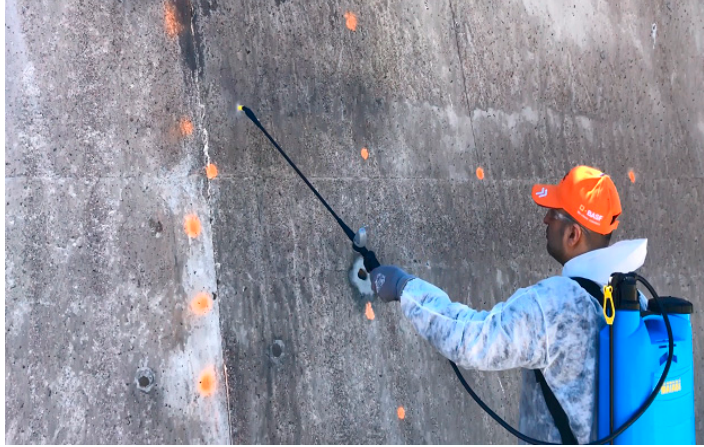
Figure 7: Application of the